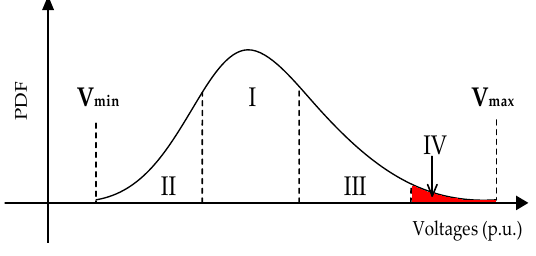
Figure 2. Probability distribution function (PDF) of Bus Voltages in regional power grid.